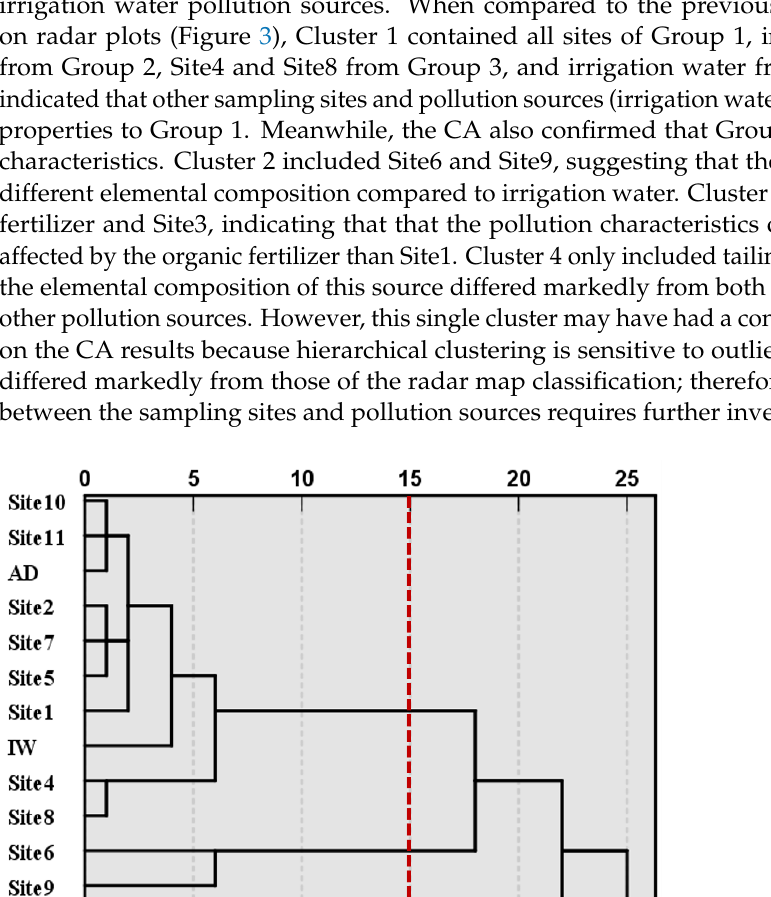
Figure 3. Radar plots of the ratios of heavy metals from different pollution sources (a, g, j, and m) and sampling sites (b, c, d, e, f, h, i, k, l, n, and o). Groups 1, 2, 3, and 4 reflect groups of sampling sites exhibiting similar radar plots as atmospheric deposition, organic fertilizer, tailings, and irri- gation water, respectively.